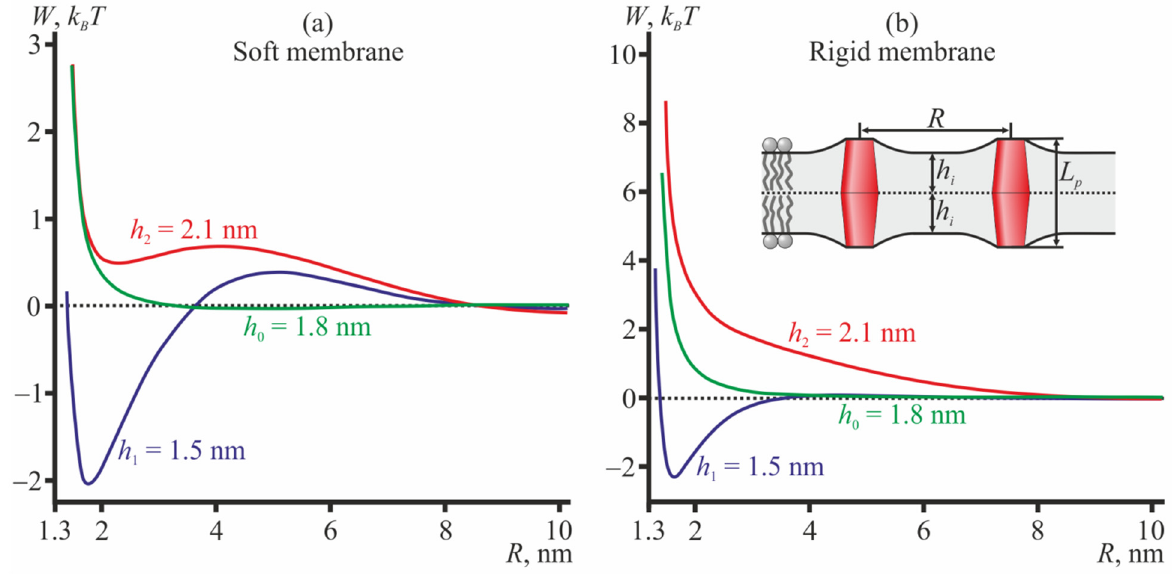
Figure 4. The interaction potentials of two barrel-like TMDs ( a ) in the disordered (soft) membrane; ( b ) in the ordered (rigid) membrane. The monolayer hydrophobic thicknesses are shown as follows: blue curves— h 1 = 1.5 nm; green curves— h 0 = 1.8 nm; red curves— h 2 = 2.1 nm. The inset in panel ( b ) illustrates two barrel-like TMDs in the thin bilayer; L p = 2 h 0 = 3.6